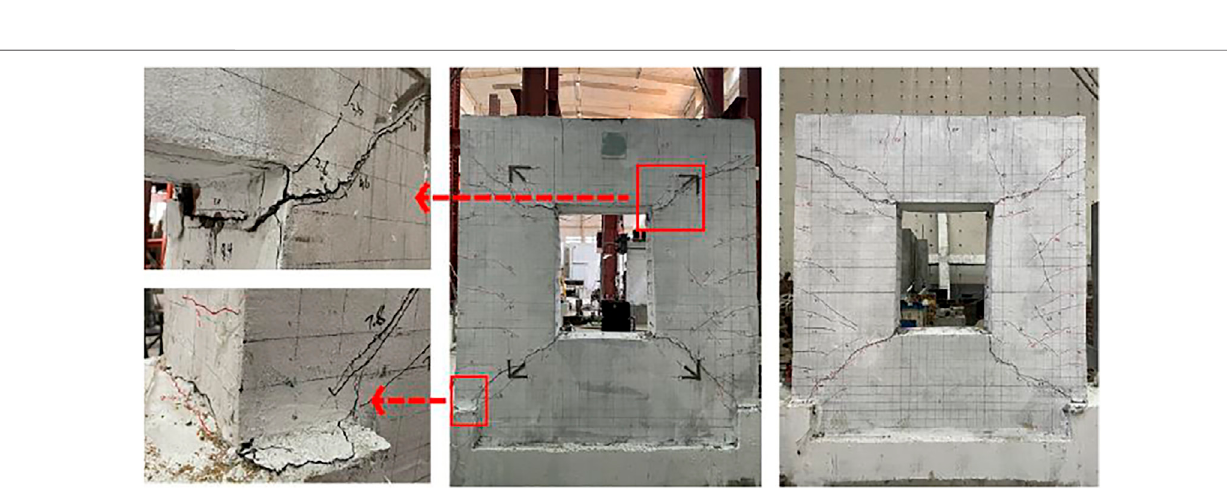
Frontiers in Materials |